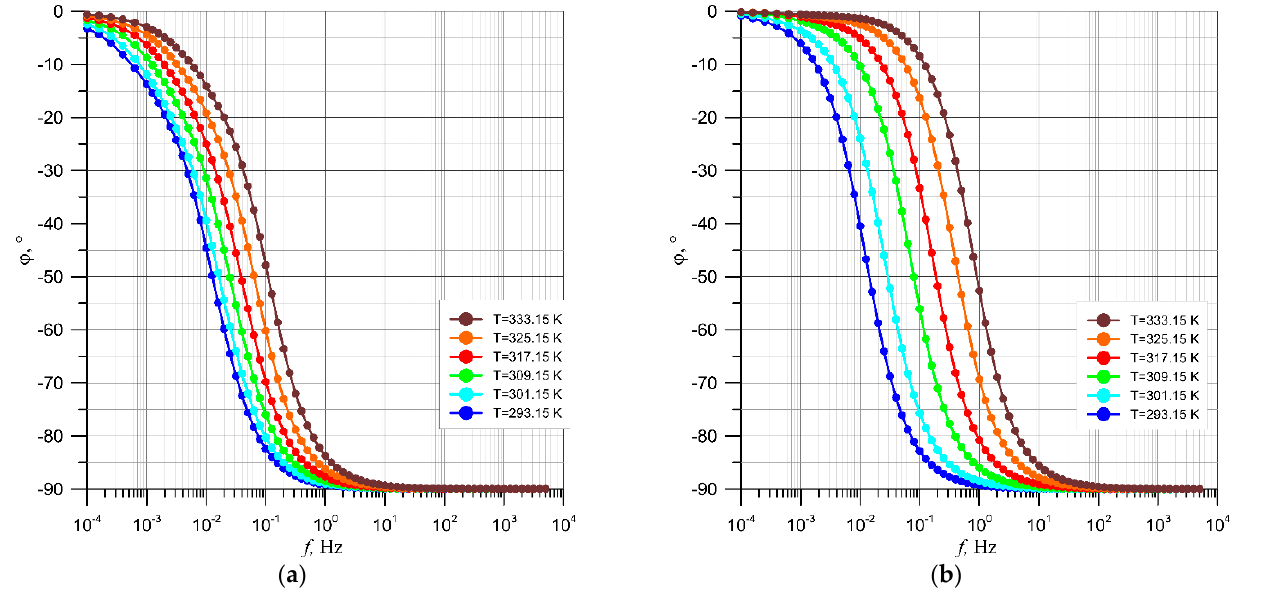
Figure 3. Frequency dependencies of the phase shift angle of mineral insulating oil with a moisture content of 5 ppm—( a ) and moistened mineral oil—( b ) at temperatures from 293.15 K to 333.15 K in steps of 8 K.